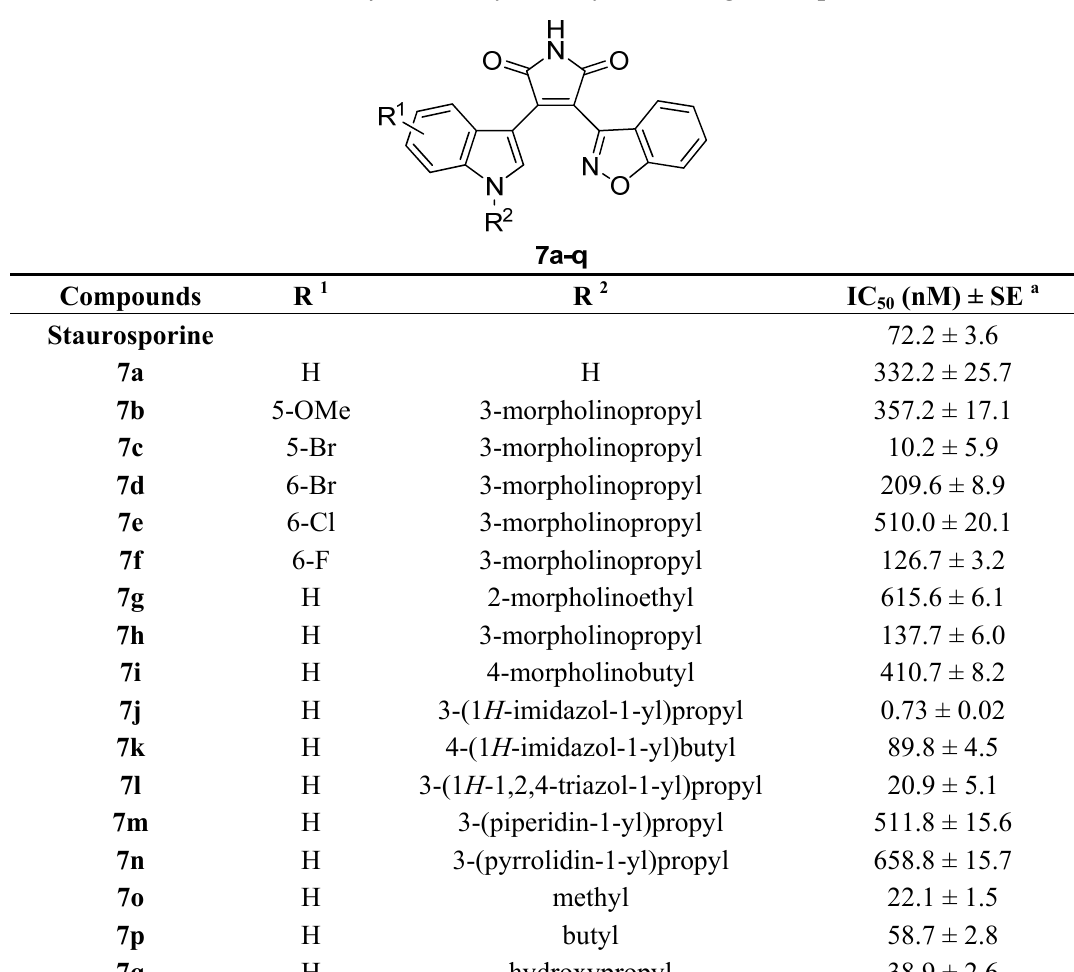
Table 1. GSK-3 β inhibitory activity of the target compounds.